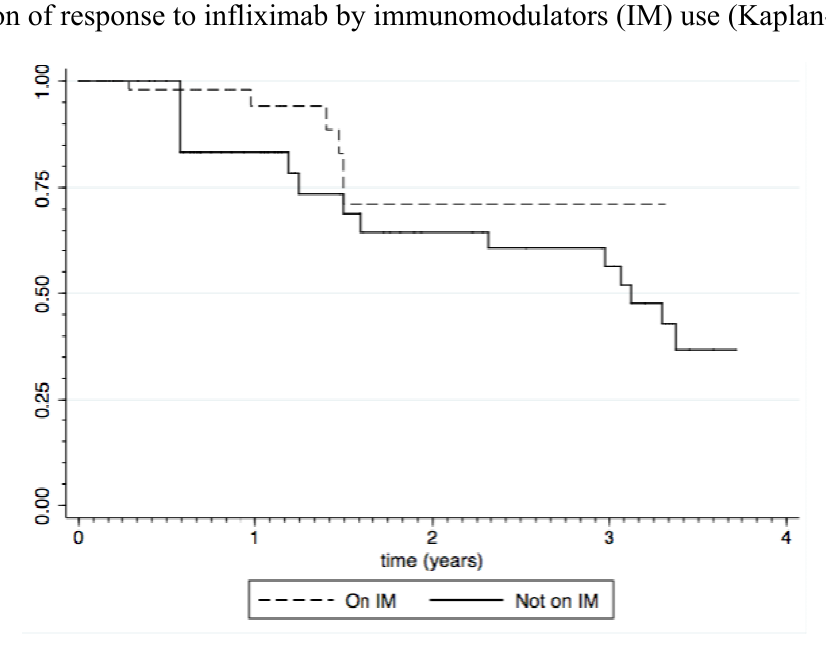
Figure 3. Duration of response to infliximab by immunomodulators (IM) use (Kaplan-Meier